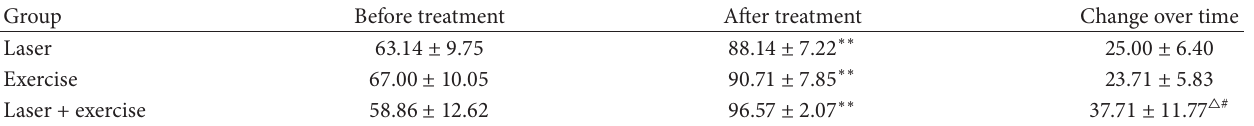
Table 2: Changes in modified-VISA score before and after treatment in all therapy